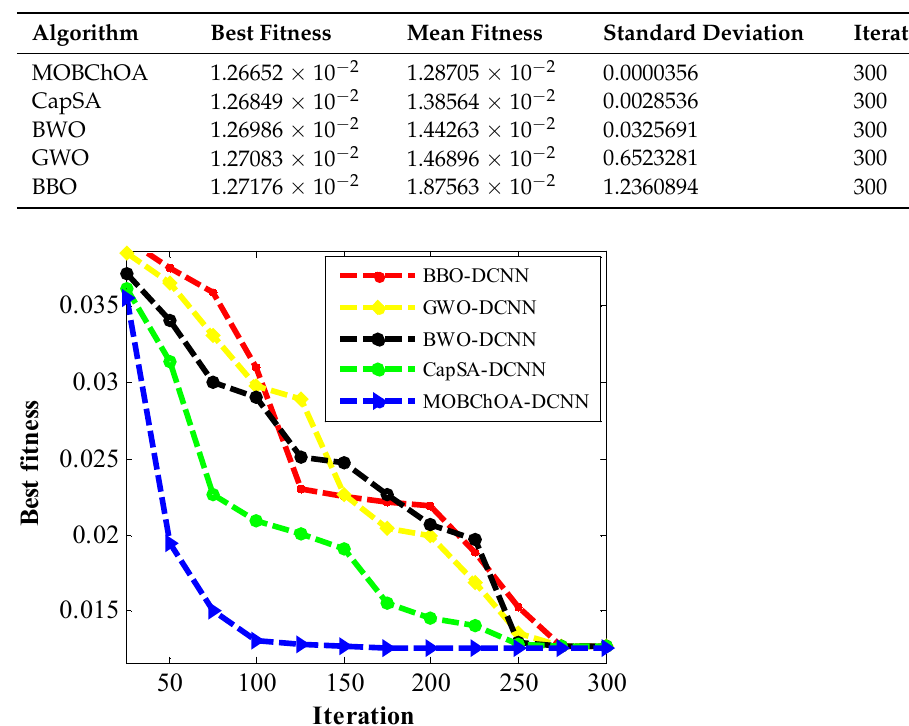
Table 4. Comparison of the results of the algorithms for spring system design.